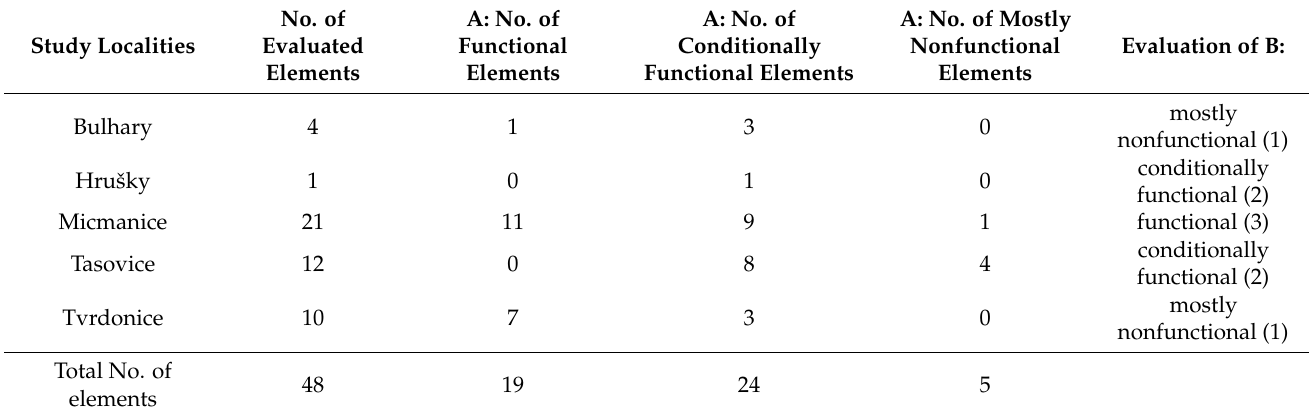
Table 3. Evaluation of windbreaks according to the category A and category